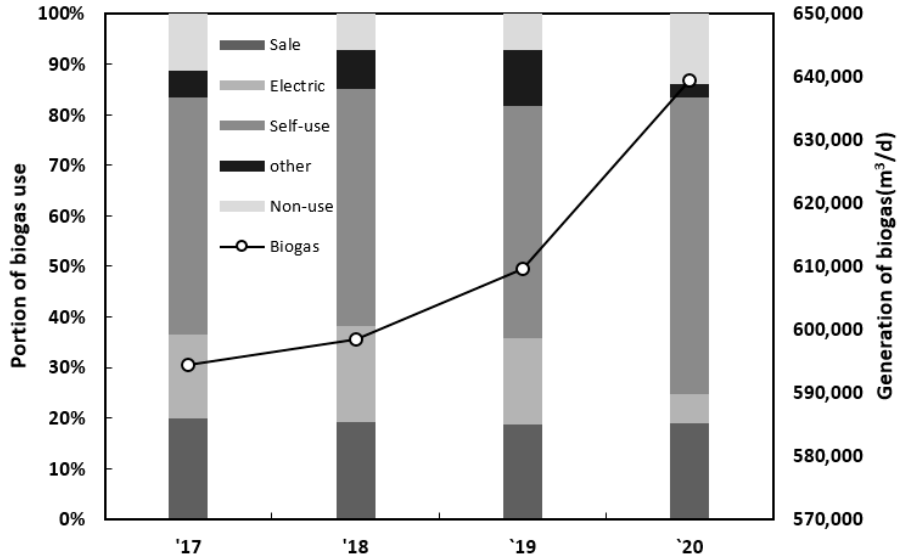
Figure 3. Status of biogas production and use in STP. The bar graph shows the change in the use rate of biogas. The line represents the change in biogas production. of biogas. The line represents the change in biogas